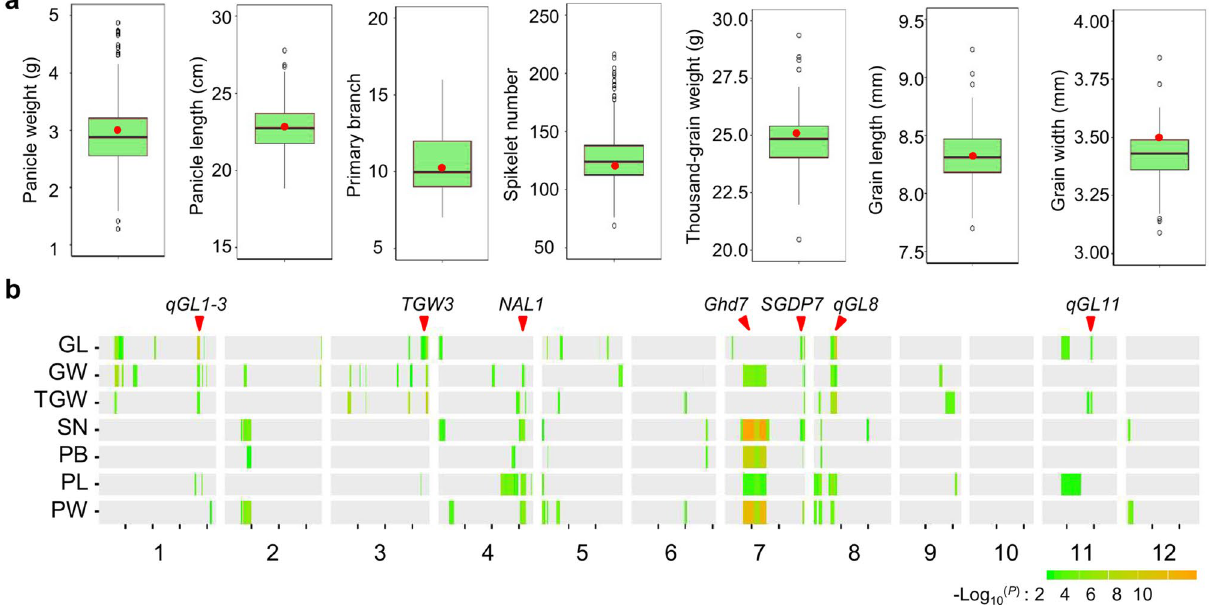
Figure 1. Phenotypic and QTL analysis of the DNZ CSSL population. ( a ) Variation of the phenotypic traits in the DNZ CSSL population. In the box plots, the horizontal line within the box indicates the median value; the bars of the box indicate the limits as 1.5 times the interquartile range from the box; the dots outside the bars indicate the most extreme data points or possible outliers. The red dot indicates the phenotype value of ZS97. ( b ) Overviews of QTL results for seven traits in the DNZ CSSL population. Rectangle color density indicates the magnitude of -log 10 ( P ) values in the ridge regression significance test. The horizontal position of the rectangle indicates the relative physical position of QTL support interval on the chromosome. The triangle indicates approximately physical location of a known gene for grain size. GL, GW, TGW, SN, PB, PL and PW represent grain length, grain width, thousand-grain weight, spikelet number, primary branch, panicle length and panicle weight, respectively. The sub-figures ( a , b ) were prepared using R software (version 3.5.2) (http://www.R-proje